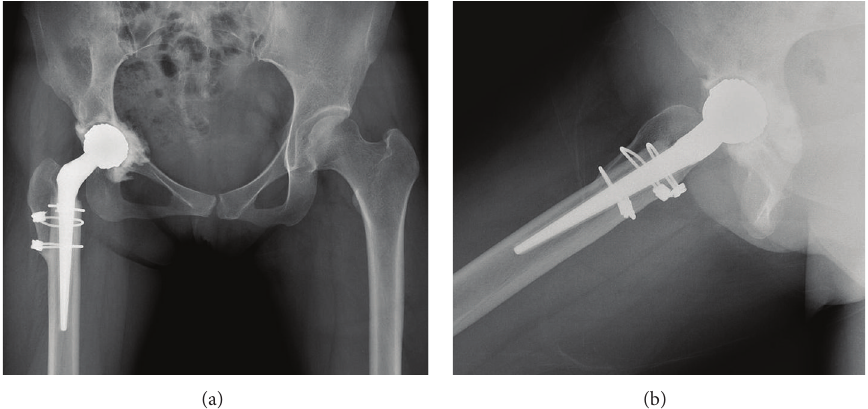
Figure 3: Postoperative radiographs taken 5 years 3 months after THA. (a) Both hip anteroposterior and (b) right hip lateral radiographs show complete bone union at the osteotomy site and no evidence of